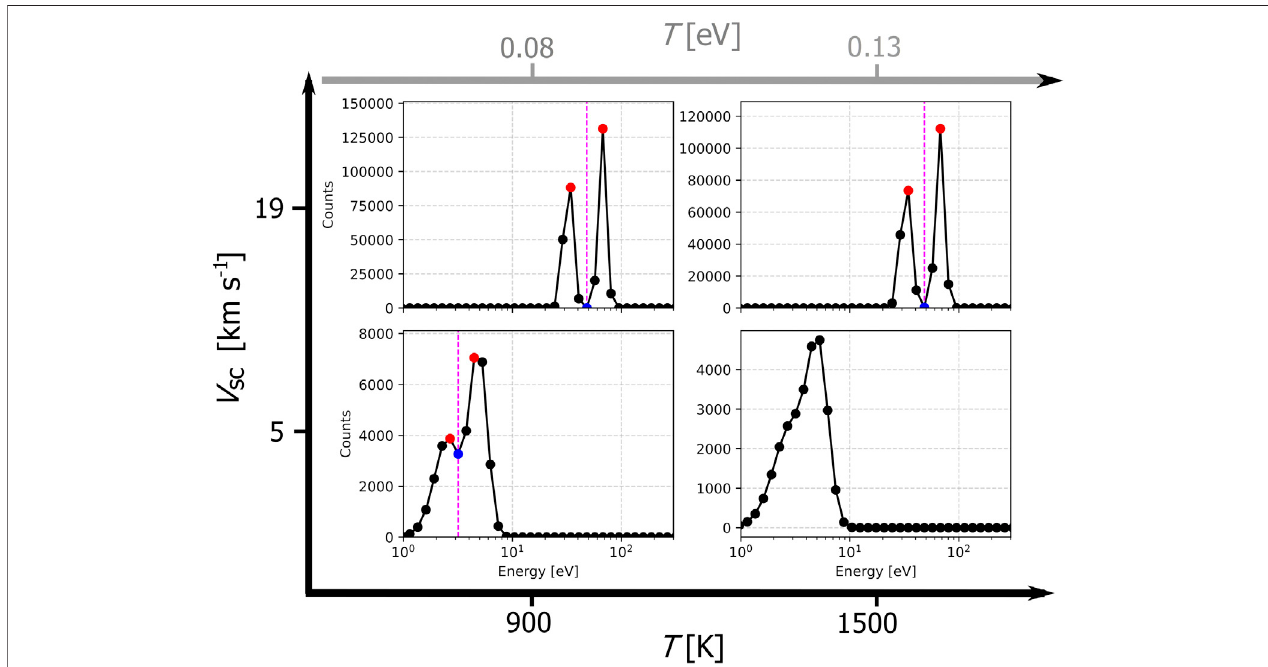
FIGURE 4 | Modeled average (expected) counts per energy for the azimuth sector Φ = 0 + , which records the maximum number of counts, for different spacecraft velocities and plasma temperatures. If the curve has a local minimum, we indicate it with a blue data-point and its energy is shown with the magenta line. For the same cases we show local maxima with red.